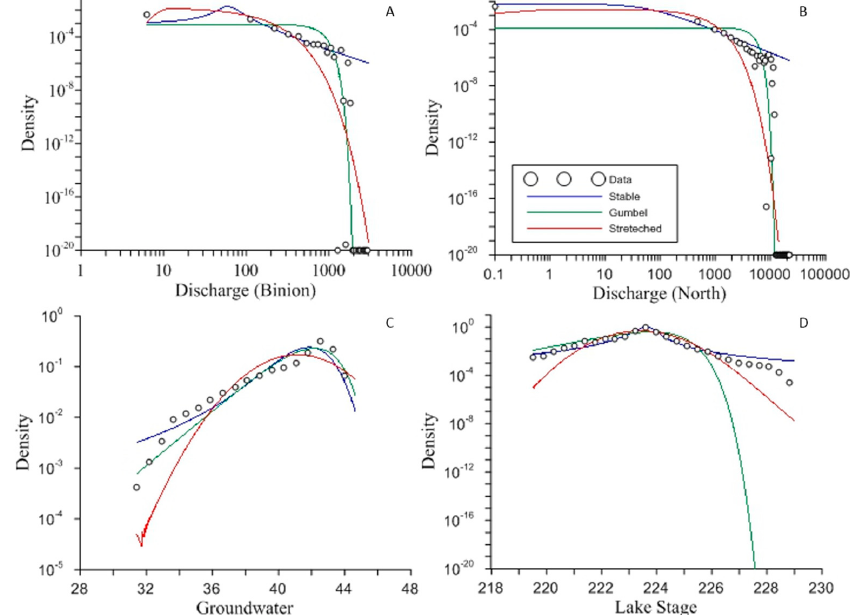
Figure 8. PDF distribution fittings for measurements of: Binion Creek discharge ( A ), North Creek discharge ( B ), depth to groundwater ( C ), and lake stage ( D ) using each of the proposed distributions: Stable (blue), Gumbel (green), and stretched Gaussian (red) compared to the actual data (white circles w/black outline).